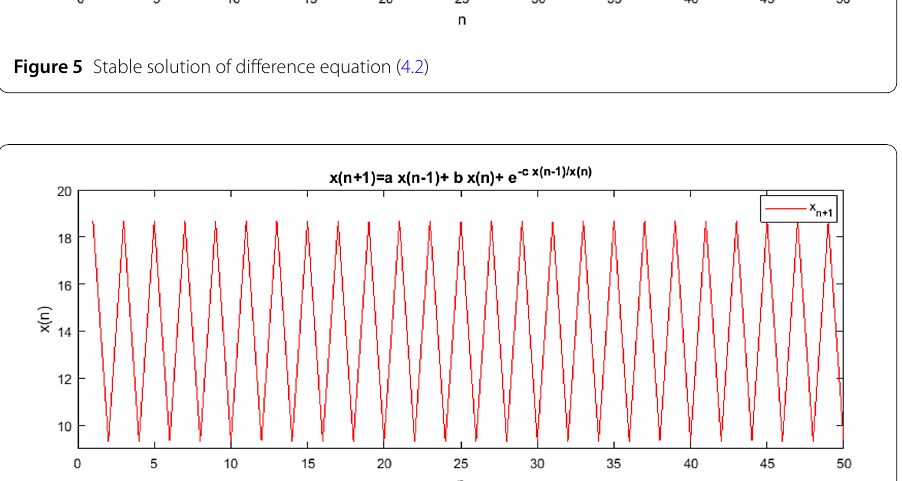
Figure 6 Prime period solution of equation